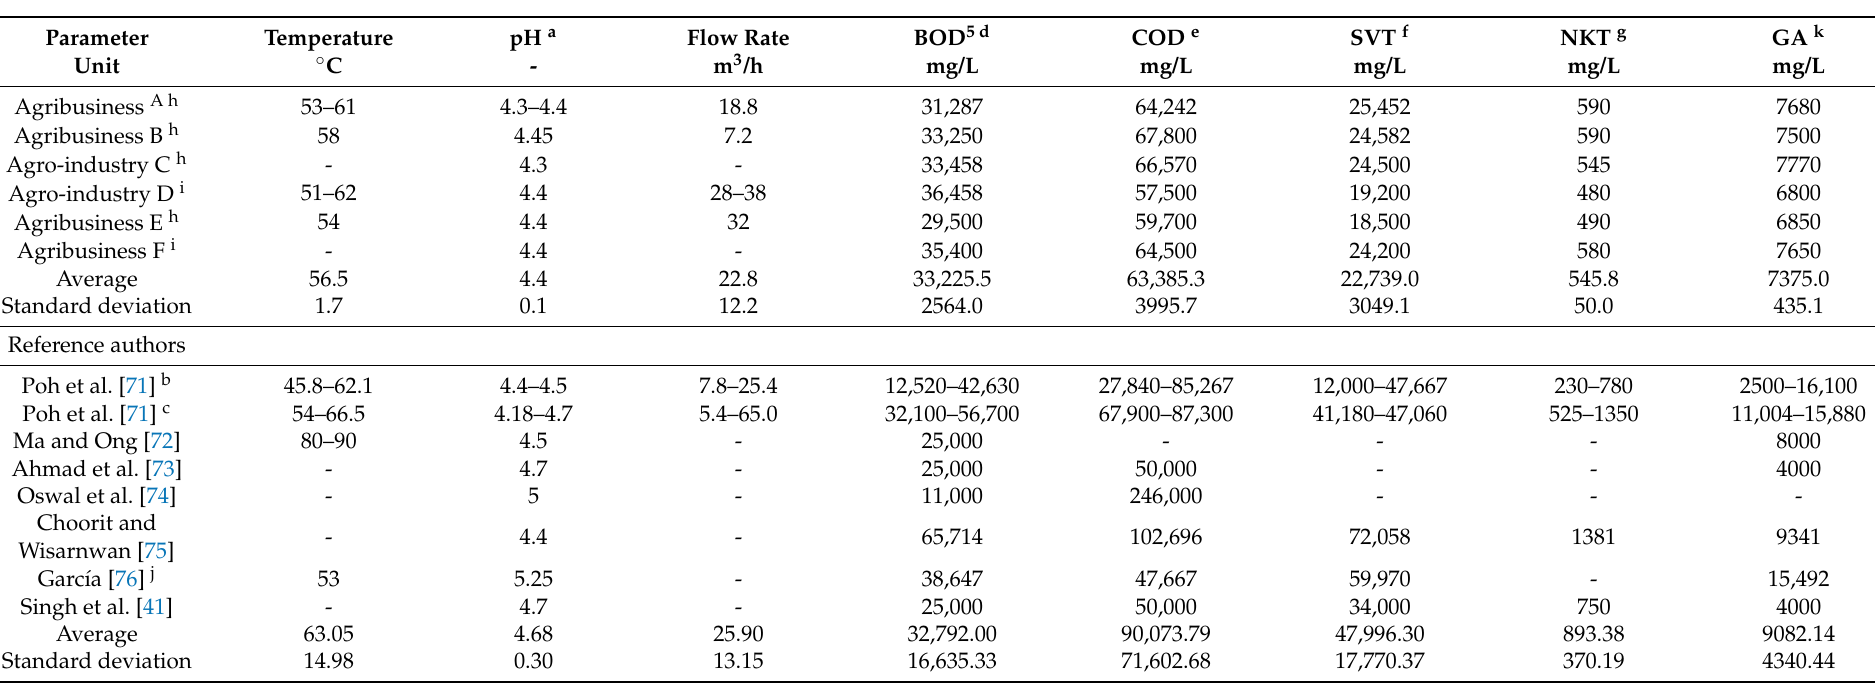
Table 7. Comparison of the physical and chemical composition of the POME from the Casanare Department’s agro-industries with the theoretical